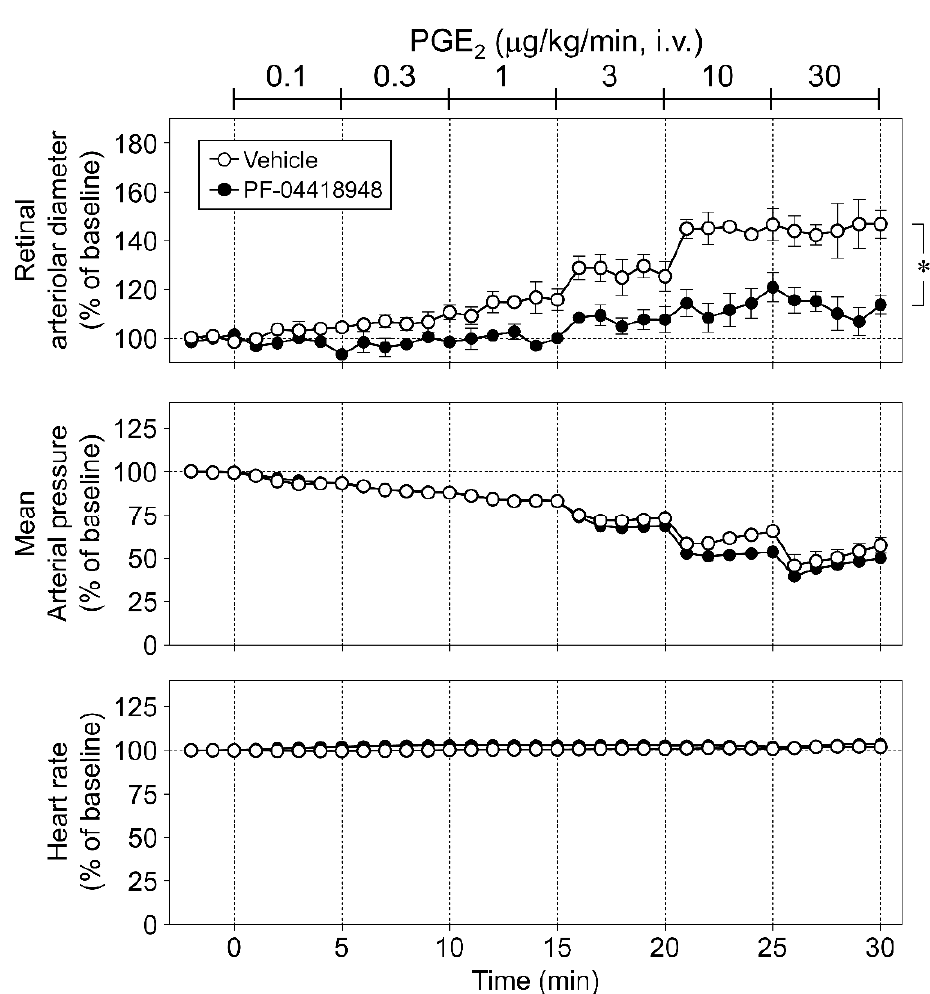
Figure 3. Involvement of prostanoid EP 2 receptors in intravenous infusion of prostaglandin E 2 (PGE 2 )-induced retinal arteriolar dilation in rats. The upper, middle, and bottom panels show the effect of PF-04418948 (20 nmol/eye) on changes in retinal arteriolar diameter, mean arterial pressure, and heart rate induced by intravenous infusion of PGE 2 (0.1–30 µg/kg/min), respectively. Each point with a vertical bar represents the mean ± S.E.M. from three animals. * p < 0.05.